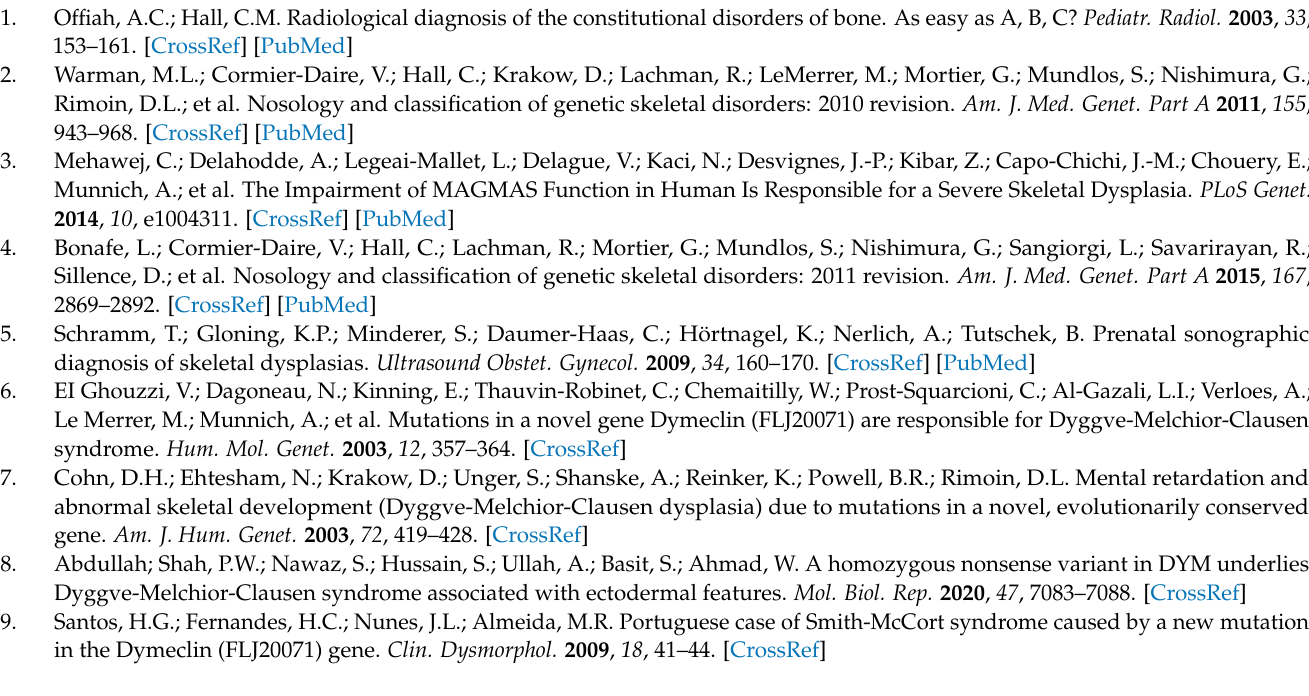
Table S1: Primer’s sequences used to amplify and sequence coding regions of DYM . Table S2: List of mutations reported in DYM till